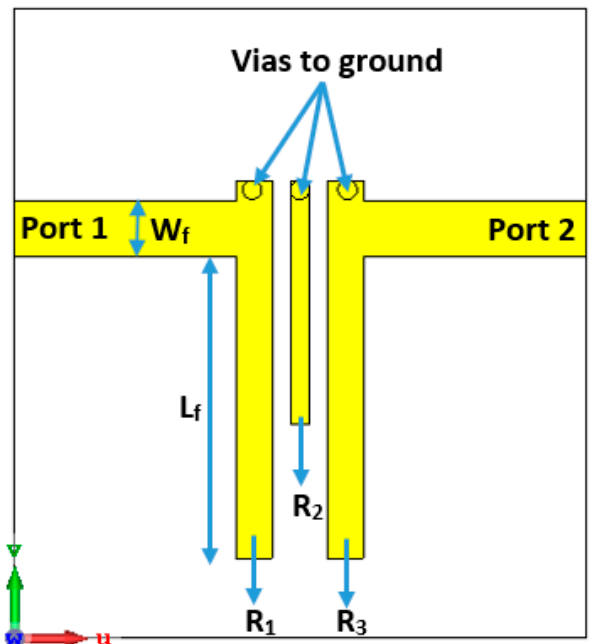
Figure 1. The geometry of the presented three-pole planar bandpass filters (BPF).